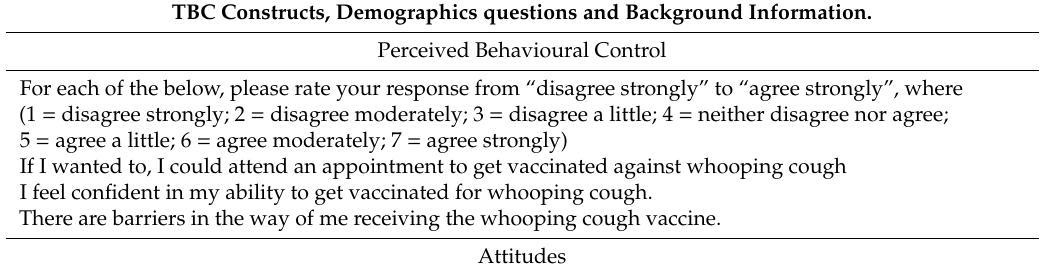
Table A4. TBC constructs, demographics questions, and background